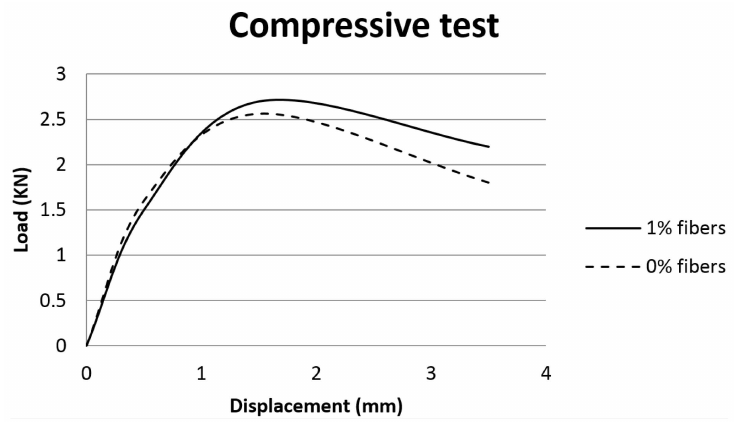
Figure 10. Load-displacement curve of compression test.